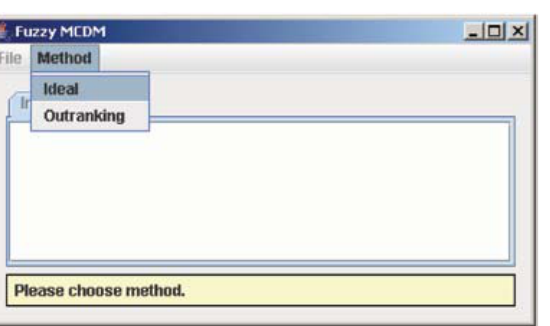
Fig. 2. Interface of the software